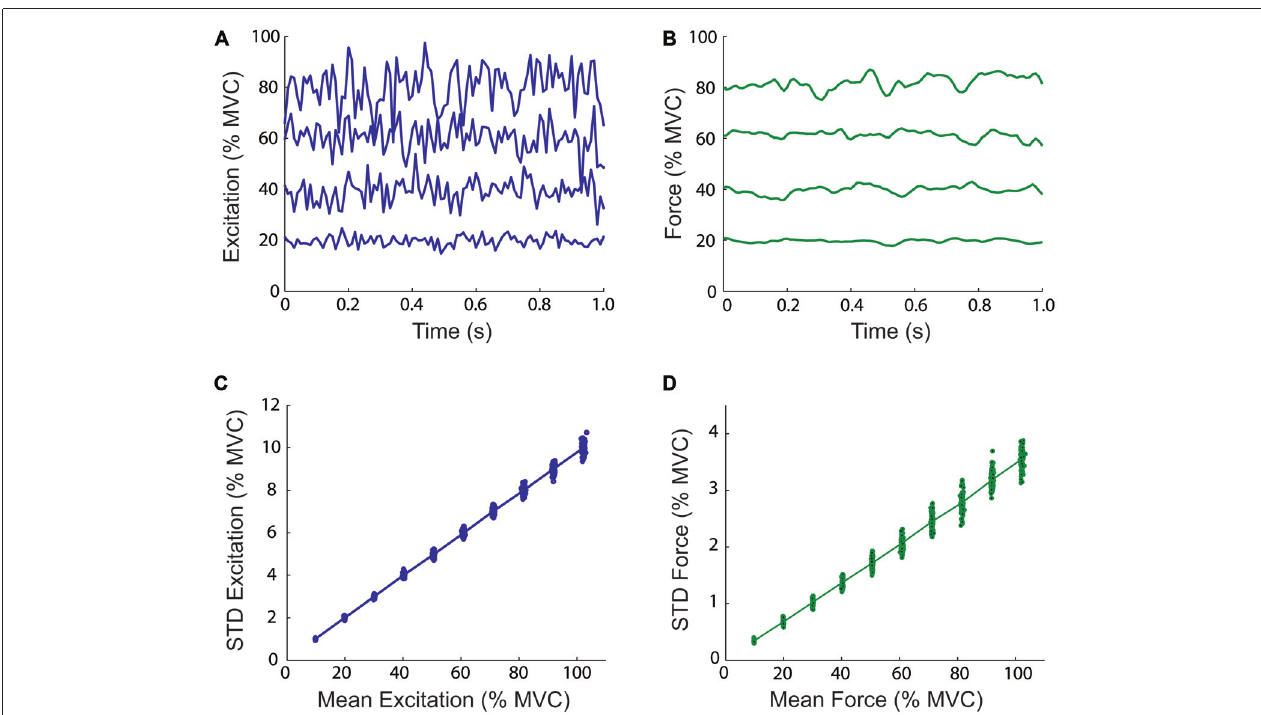
FIGURE 3 | Magnitude and variability of virtual arm neural control signals and virtual muscle forces. The top panels show one-second examples of simulated neural excitation time-histories (A) and resulting virtual muscle force (B) at 20, 40, 60, and 80% of maximal voluntary contraction (MVC) during simulated isometric efforts of the biceps lumped muscle model. The total virtual muscle-tendon length was fixed at 0.3051 m (the length when the virtual arm was at 90 ◦ of elbow flexion). The bottom panels show the relationship between the mean and standard deviation (STD) excitation (C) and muscle model force (D) over 10 s at different mean excitation levels from 10 to 100% in 10% increments (100 simulations were performed at each excitation level).